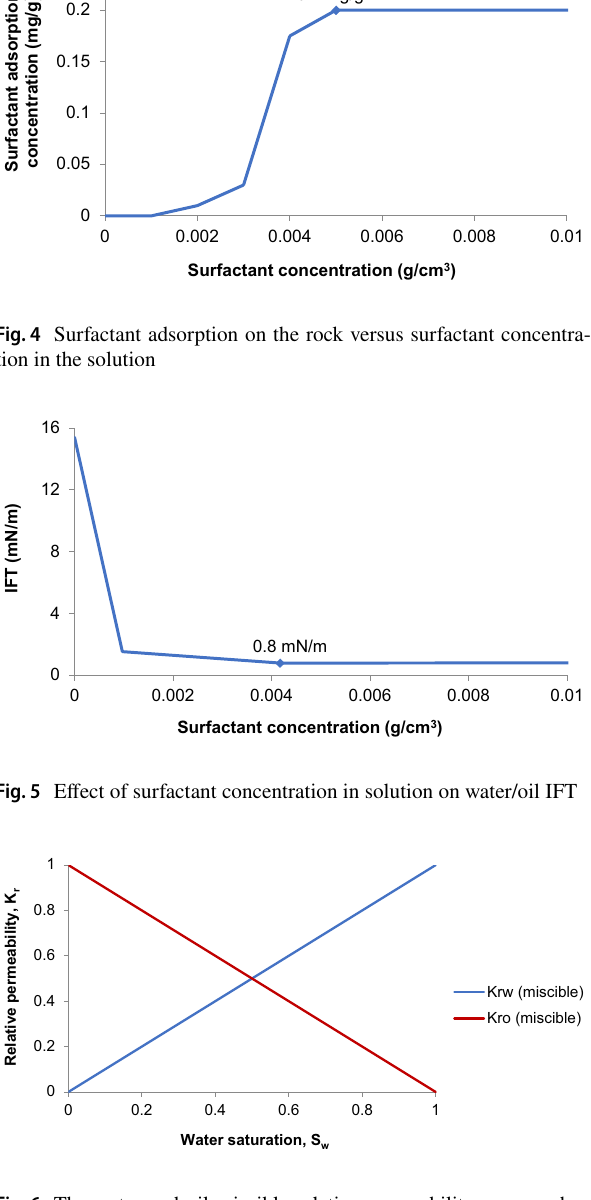
Fig. 6 The water and oil miscible relative permeability curves when the capillary number is larger than 10 −3